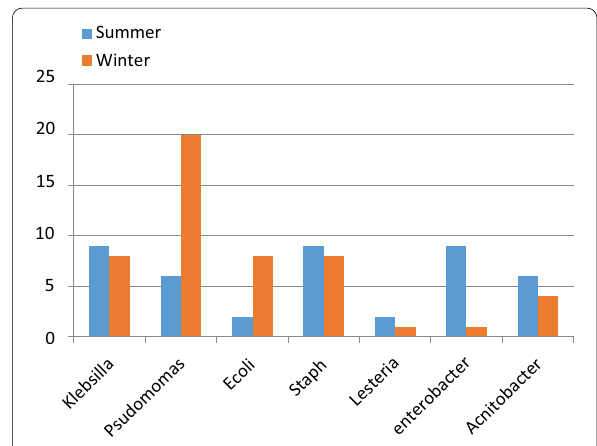
Fig. 1 Comparison between both seasons regarding bacterial isolates from the blood culture